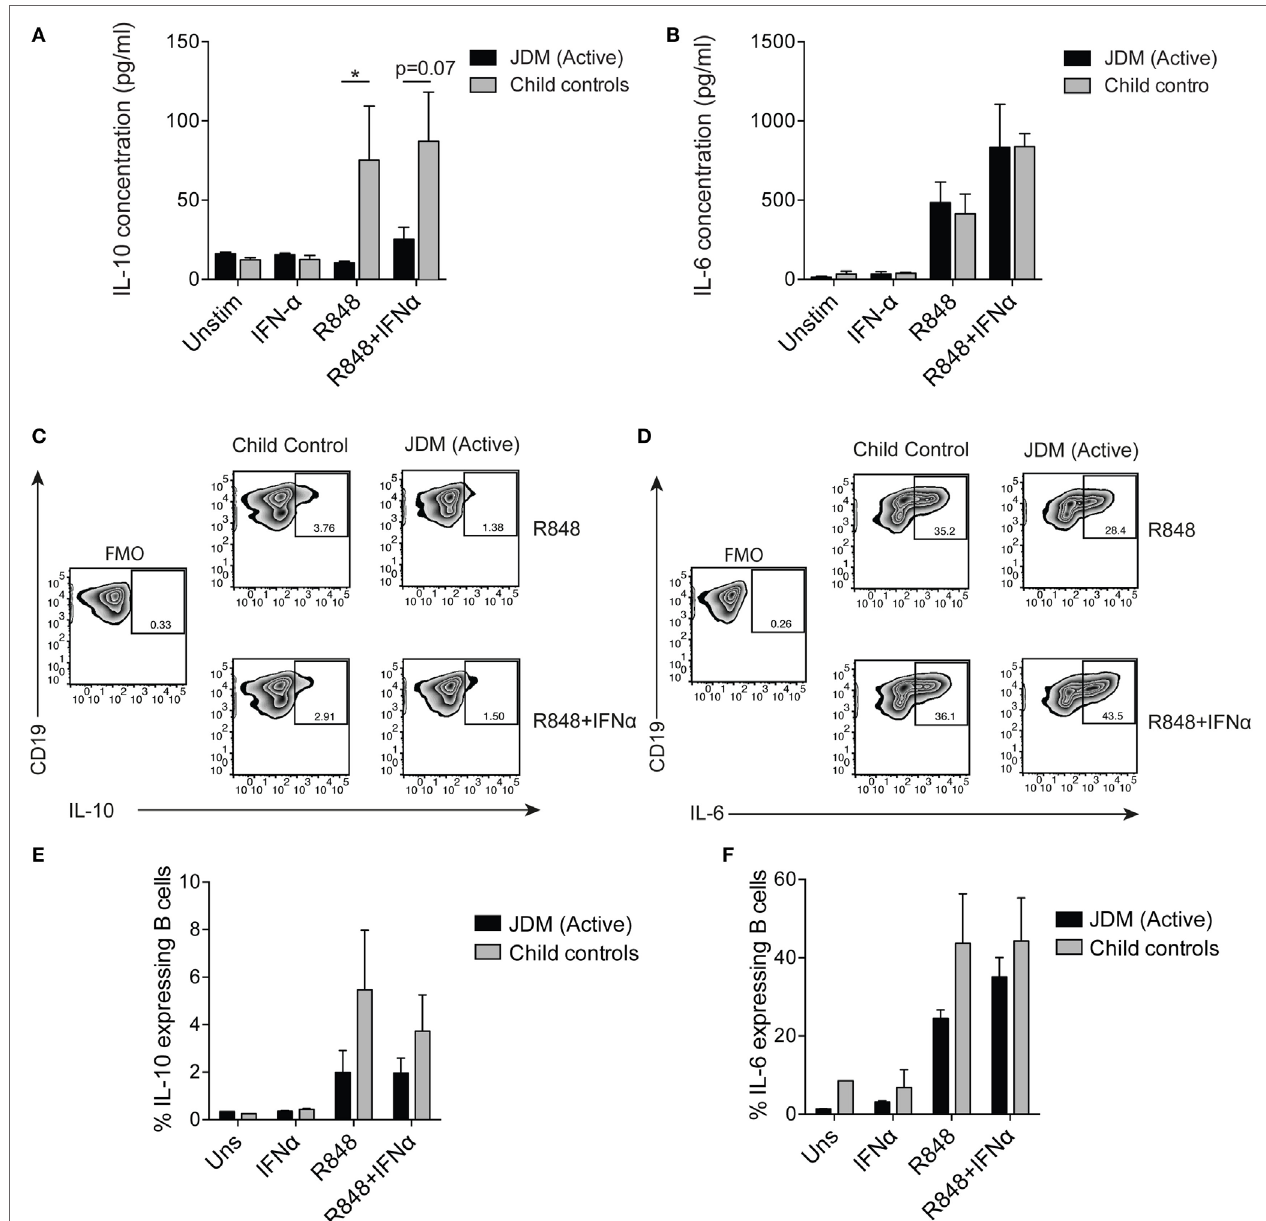
FigUre 4 | Juvenile dermatomyositis (JDM) B cells fail to induce IL-10 after TLR7 stimulation. B cells purified from active on-treatment patients [patients with flares had high disease activity (Physicians Global Assessment > 3.5) and were > 6 months into treatment], and age-matched child control peripheral blood mononuclear cells, were stimulated with interferon alpha (IFN α ) (1,000 IU/ml), 1 µg/ml R848 (a TLR7/8 agonist) or both, for 48 h. Culture supernatants taken from total B cells at 48 h were analyzed for (a) IL-10 and (B) IL-6 concentrations for patients and controls. Representative flow cytometry plots showing percentages of (c) IL-10 + and (D) IL-6 + B cells after 48 h stimulation with R848 (top row) and R848 + IFN α (bottom row). FMO plots are also shown for each cytokine. The frequencies of (e) IL-10 + and (F) IL-6 + B cells for child controls and active JDM patients are summarized. A two-way analysis of variance with Sidak multiple comparisons test was used for panels (a,B,e,F) . N = 3 for both patients and controls. For panel (a,B,e,F) , bars represent mean ± SEM (* p <